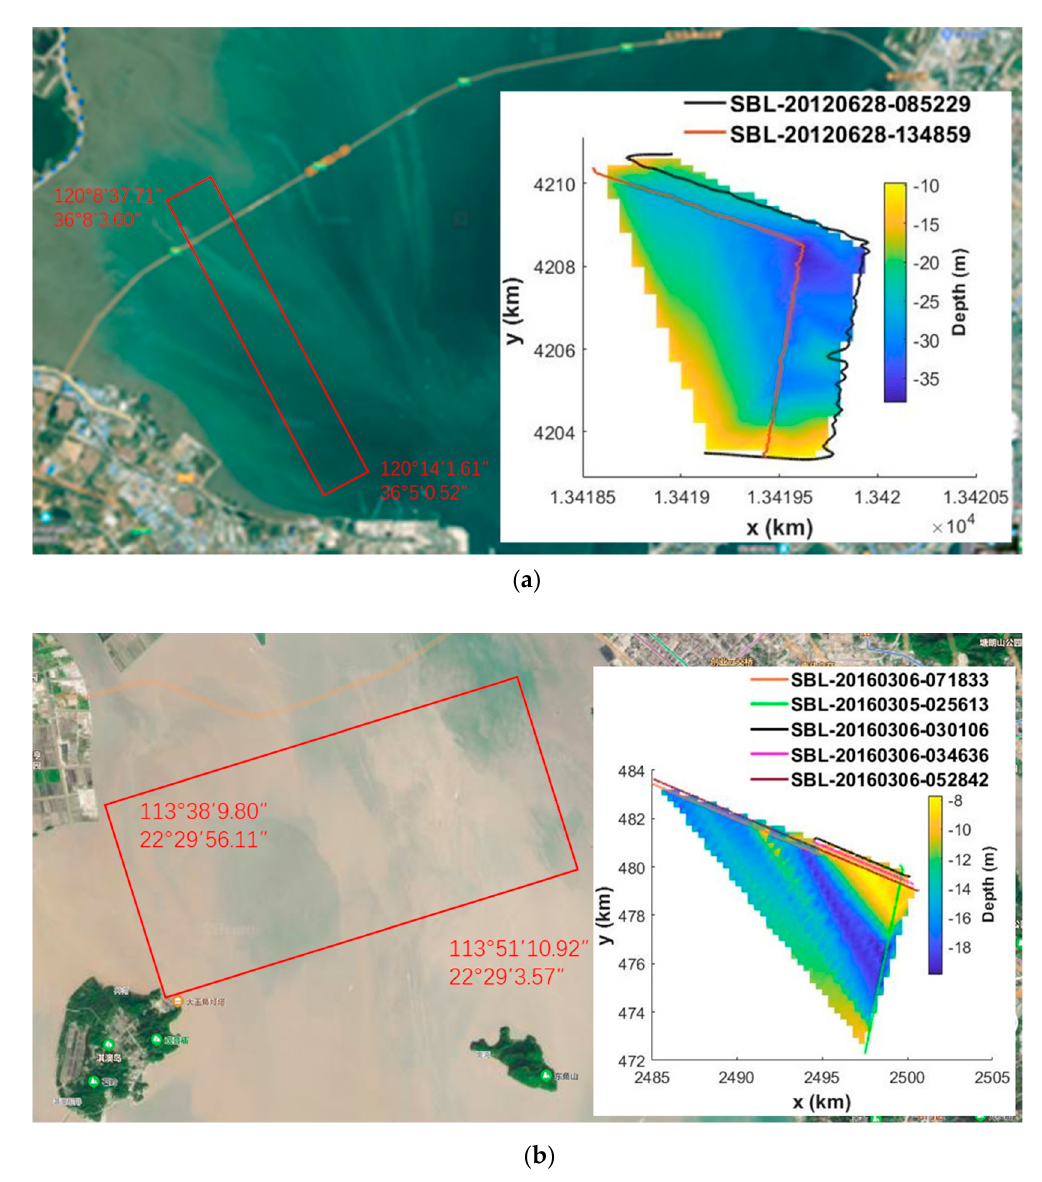
Figure 10. Survey areas. ( a ) Jiaozhou Bay. ( b ) Zhujiang Estuary. The coordinate system of longitudes and latitudes is WGS-84. The red rectangles represent the survey areas. The illustrations are the corresponding topographic map. The coordinate system of x and y is a local system. Table 1. The size of collected SBP images.